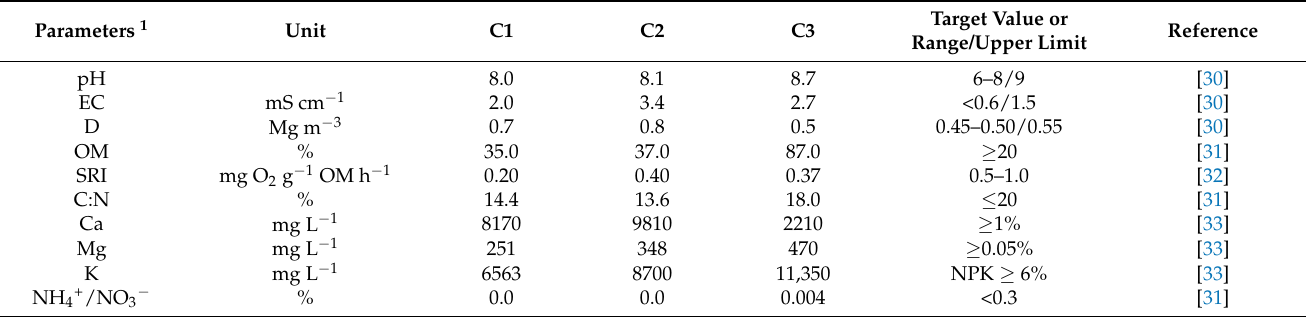
Table 2. Physicochemical characterization of composts used in the substrate